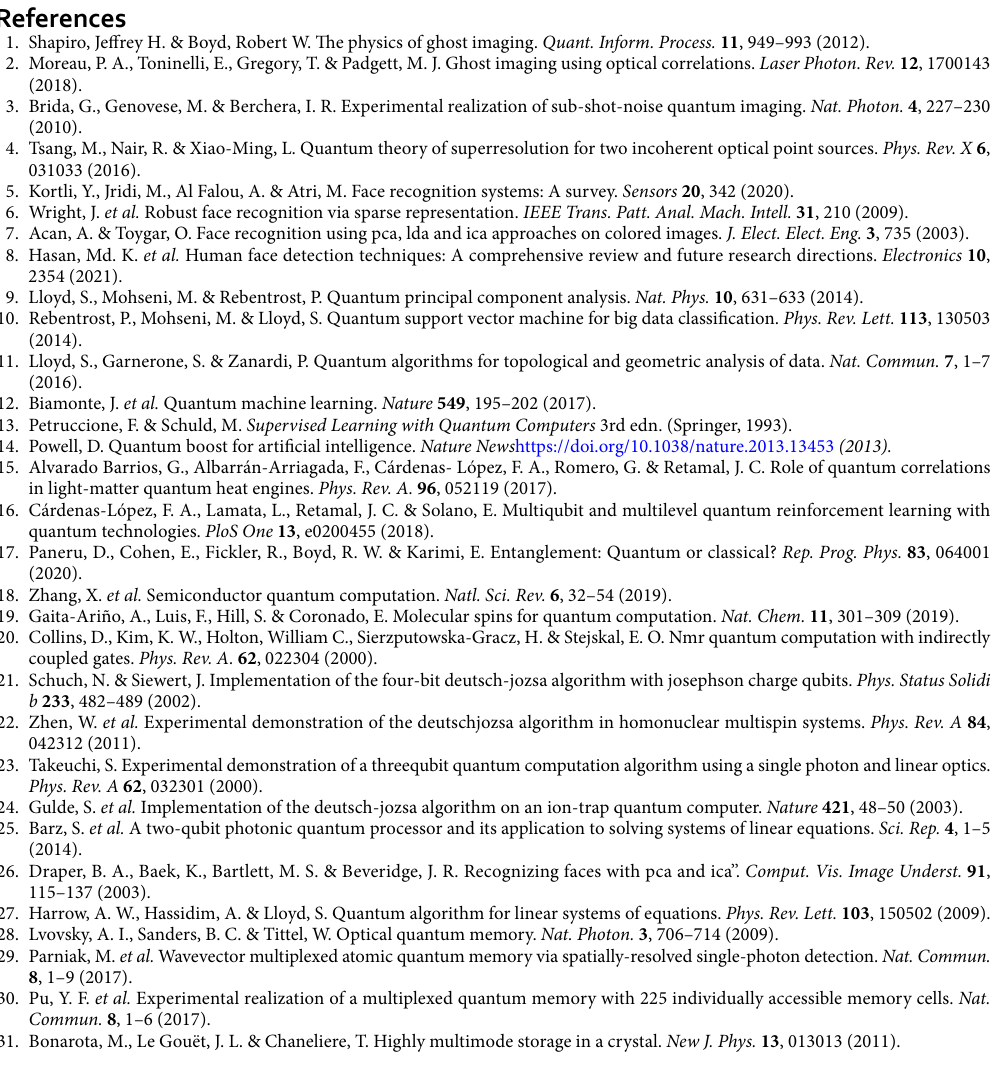
Table 4. Numerical estimates of the Signal to Noise ratio (SNR) in the ghost images of different dimensions along with the total number of photons acquired corresponding to different acquisition times.